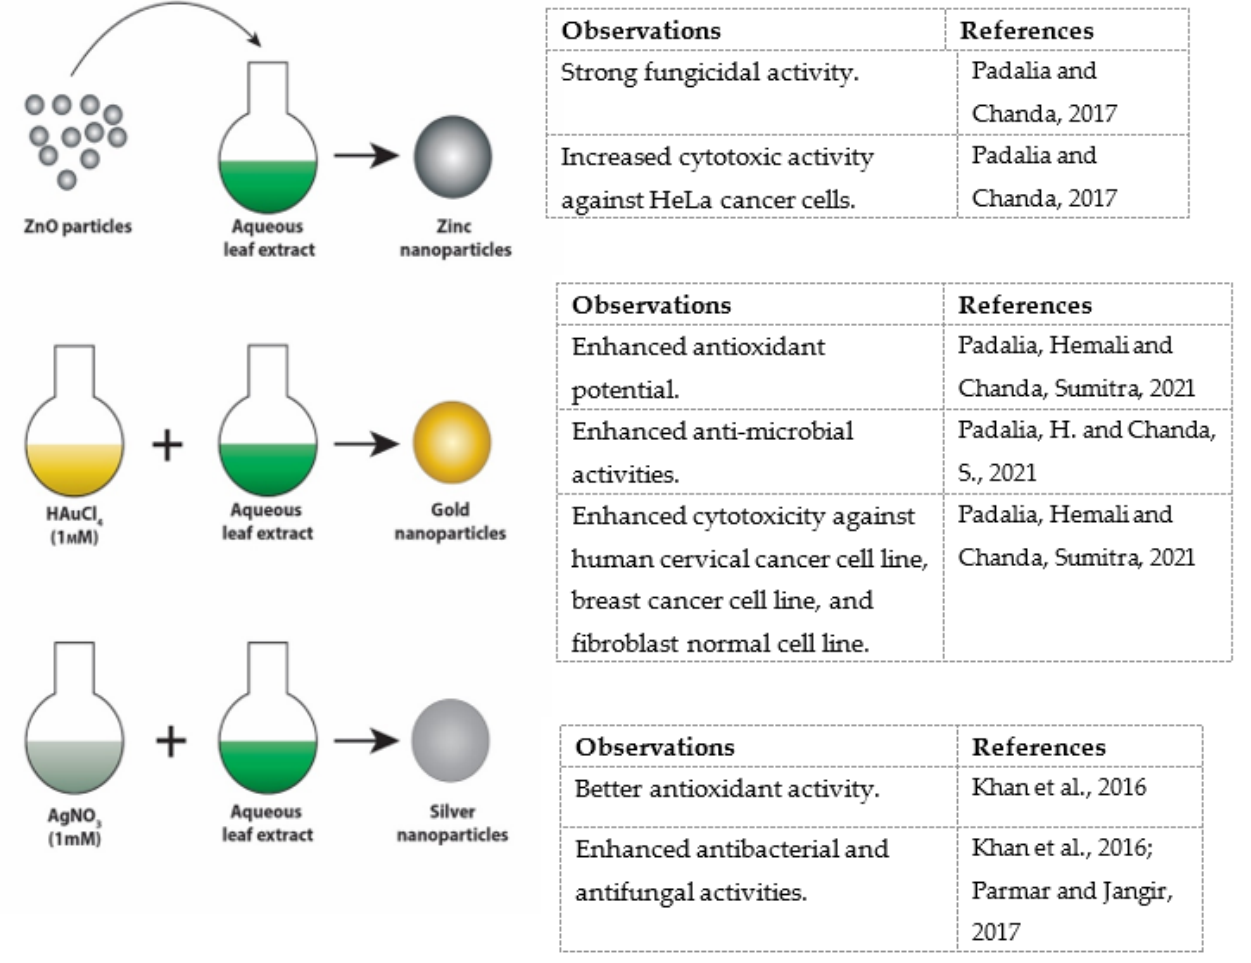
Figure 3. Reported therapeutic applications of Ziziphus nummularia . Padalia and Chanda, 2017 [97]; Padalia, H. and Chanda, S., 2021 [98]; Padalia, H. and Chanda, S., 2021 [96], Khan et al., 2016 [94]; Parmar and Jangir, 2017 [95] .